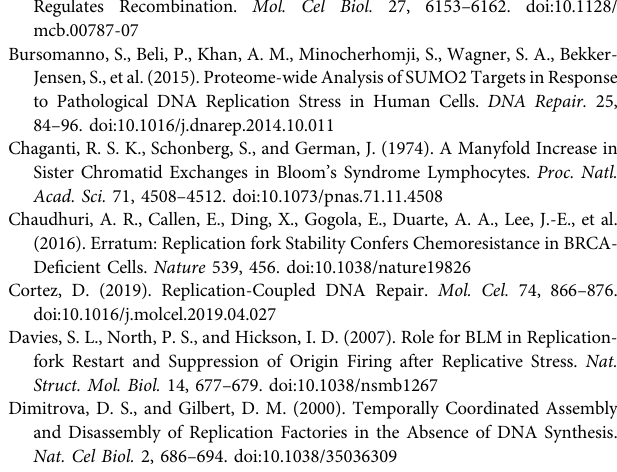
Supplementary Figure S1 | (A) Bar graphs showing results of clonogenic survival assays on RNF4-depleted and control-depleted U2OS cells exposed to varying concentrations of HU. Results from three independent assays were averaged and standard deviations shown. (B) Bar graphs showing results of clonogenic survival assays on RNF4-depleted and control-depleted U2OS cells exposed to varying concentrations of camptothecin (CPT) for three hours. Results from three independent assays were averaged and standard deviations shown. (C) Bar graphs showing the relative levels of DSBs in RNF4-depleted and control-depleted HeLa cells exposed to varying concentrations of CPT for three hours, as determined by pulsed fi eld gel electrophoresis. Induced DSBs were normalized to DSBs in untransfected and untreated cells. Results from three independent experiments were averaged and standard deviations shown. (D) Box and whiskers plot showing the quanti fi cations of focal areas of RAD51 focal accumulations, in RNF4-depleted and control-depleted cells with and without treatment with 2 mM HU for 16 h. RAD51 localized to PML nuclear bodies in untreated cells, and PML bodies have been noted to enlarge in RNF4-depleted cells. Results from three independent experiments were combined. NT, not treated. Supplementary Figure S2 | Proliferation defect in RNF4-depleted HCT116 cells exposed to 2 mM HU for 16 h. Results from three independent experiments with standard deviations are shown. SupplementaryFigureS3| (A) BLM stabilitywasunaffected byRNF4depletionin HeLa cells treated with cycloheximide. Cycloheximide was added at time zero and treated cells examined hourly for six hours. Untreated control examined at six hours is indicated by an asterisk. Note that RNF4 levels were reduced by more than half after 2 h. (B) Representative indirect immuno fl uorescence image of BLM and RPA foci detected in HeLa cells transfected with negative control and RNF4 siRNAs and treated with 2 mM HU for 16